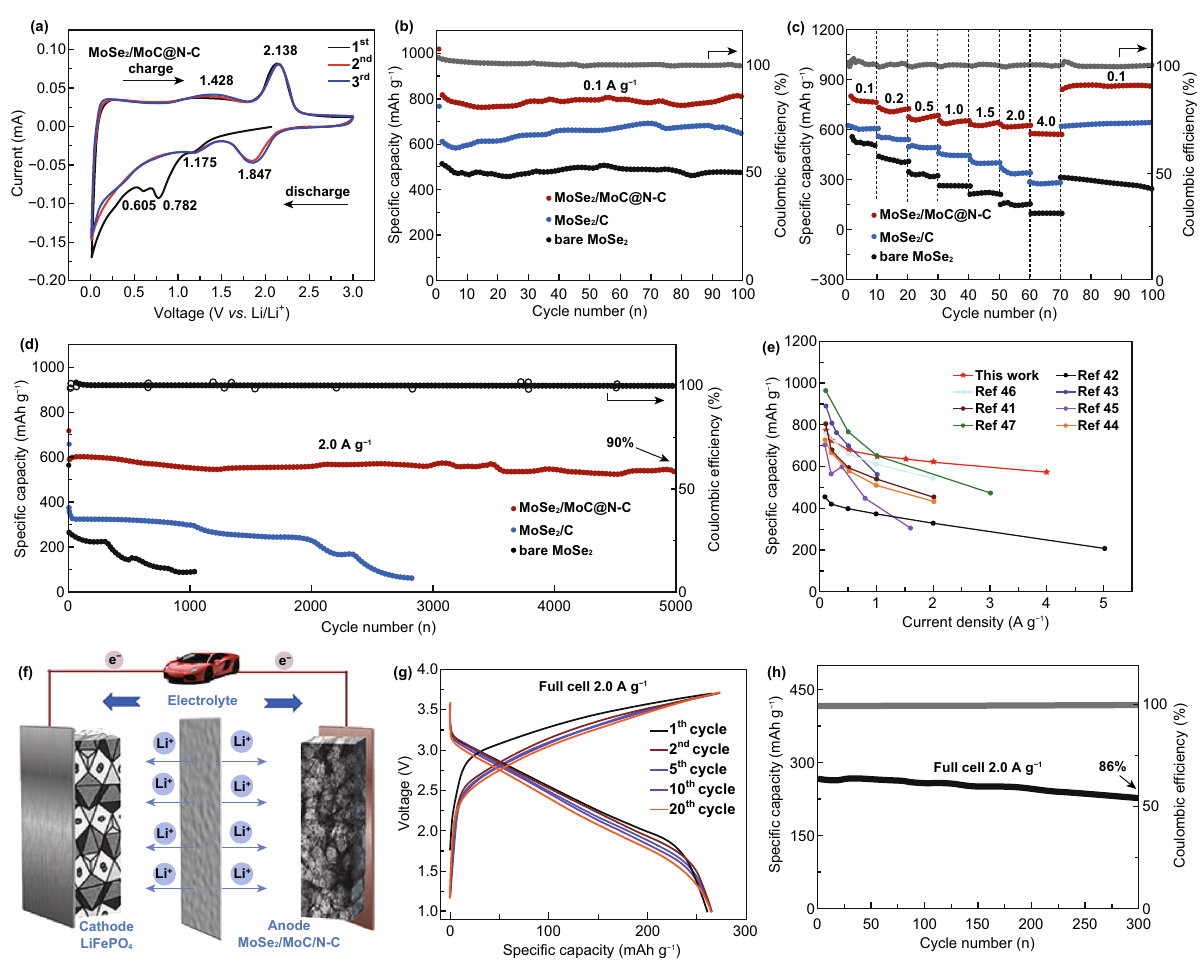
Fig. 3 a Initial three cyclic voltammograms cycles of the MoSe 2 /MoC/N–C electrode at a scan rate of 0.1 mV s −1 . b Cycling performance (0.1 A g −1 ), c rate performances, and d long‑term cycling performances (2 A g −1 ) of bare MoSe 2 , MoSe 2 /C, and MoSe 2 /MoC/N–C electrodes between 0.01 and 3 V versus Li/Li + . e Comparison plot of rate performance between this work and previously published MoSe 2 /C composite‑ related works. f Schematic illustration of the LiFePO 4 //MoSe 2 /MoC/N–C full‑cell configuration. g Charge/discharge profiles of the full cell. h Cycling performance of the full cell at 0.1 A g